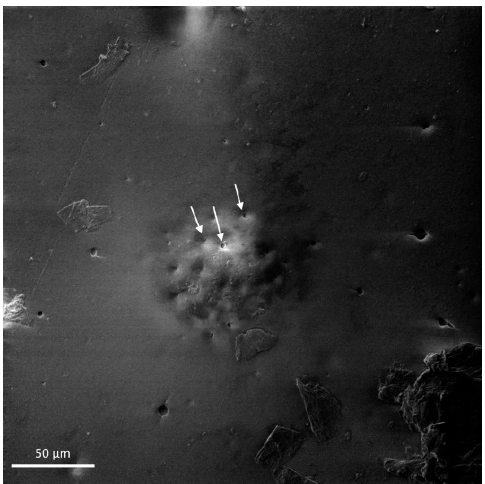
Figure 9. MC coating with a large microcapsule pictured in the center after electrochemical testing in SCPS. Arrows indicate pores from the microcapsules.